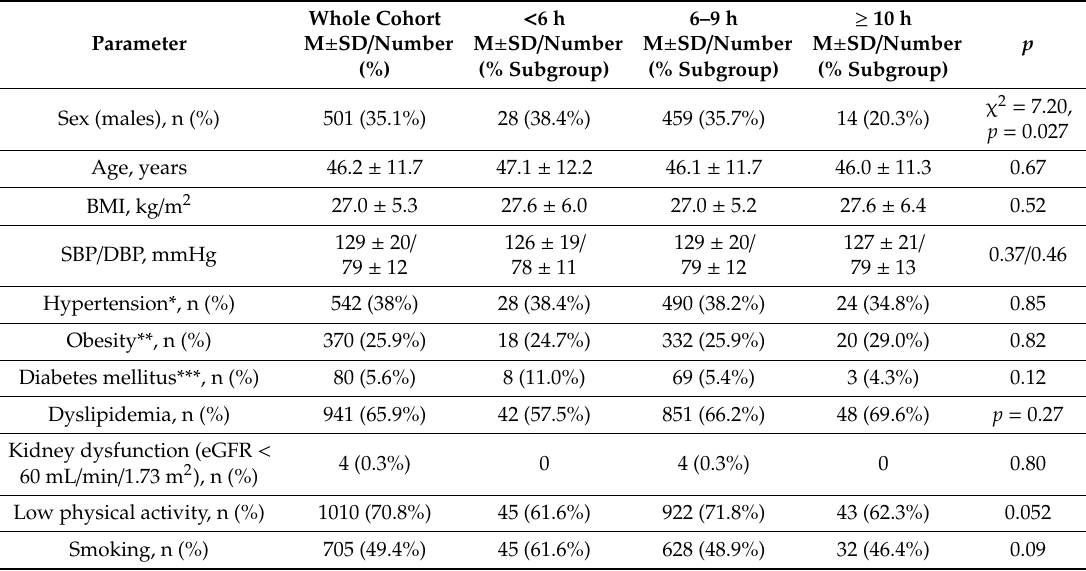
Table 2. Demographic and clinical characteristics of the groups depending on sleep